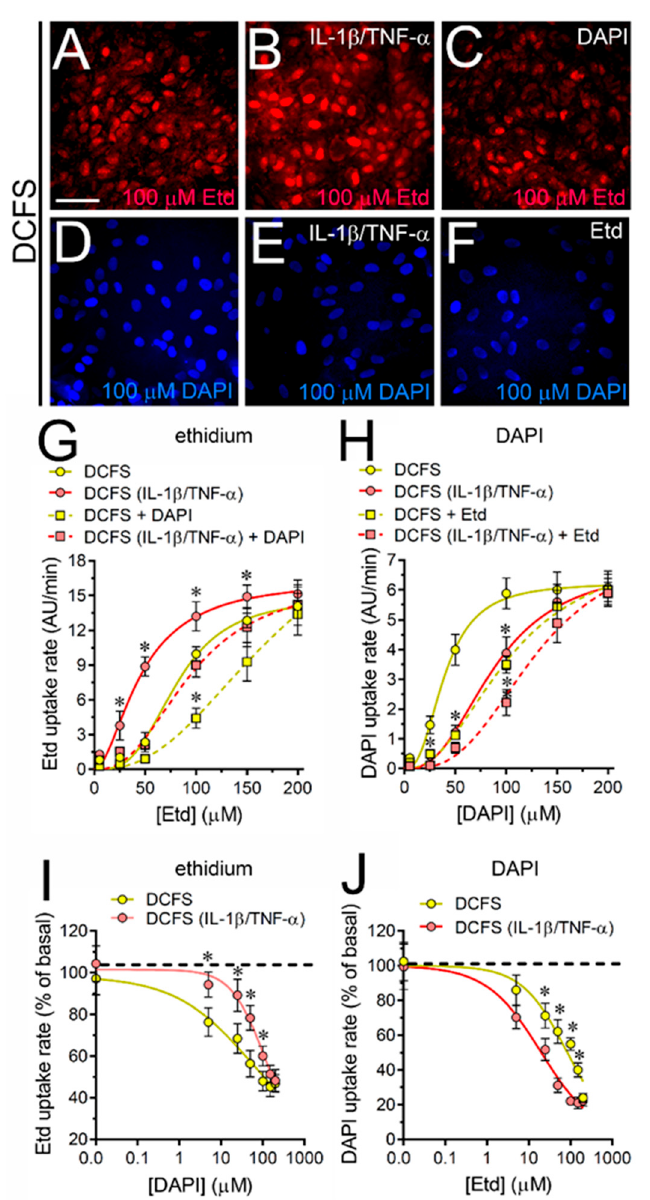
Figure 5. IL-1 β plus TNF- α modulates the competitive permeation of cationic dyes through Cx43 hemichannels depending on the permeant species in cultured astrocytes. ( A – F ) Representative fluorescence images depicting Etd ( A – C ) and DAPI ( D – F ) staining from dye uptake measurements (10 min exposure to 100 µM each dye) in astrocytes bathed with DCFS under control conditions ( A , D ), after 24 h of treatment with IL-1 β /TNF- α ( B , E ) or in the presence of 150 µM DAPI ( C ) or Etd ( F ). ( G ) Relationship between Etd uptake rate and increasing concentrations of Etd by astrocytes bathed with DCFS under control conditions alone (yellow circles) or plus 150 µM DAPI (yellow squares); or after treatment with IL-1 β /TNF- α alone (red circles) or plus 150 µM DAPI (red squares). ( H ) Relationship between DAPI uptake rate and increasing concentrations of DAPI by astrocytes bathed with DCFS under control conditions alone (yellow circles) or plus 150 µM Etd (yellow squares); or after treatment with IL-1 β /TNF- α alone (red circles) or plus 150 µM Etd (red squares). Data were fitted using an empirical equation for sigmoidal binding-velocity curves (see methods). * p < 0.05, control DCFS vs. treatments (two-way ANOVA followed by Tukey’s post hoc test). ( I ) Etd uptake rate normalized to the maximum effect evoked by DCFS in control (yellow circles) or IL-1 β /TNF- α -treated (red circles) astrocytes exposed to increasing concentrations of DAPI. ( J ) DAPI uptake rate normalized to the maximum effect evoked by DCFS in control (yellow circles) or IL-1 β /TNF- α -treated (red circles) astrocytes exposed to increasing concentrations of Etd. Data were fitted using the [inhibitor] vs.